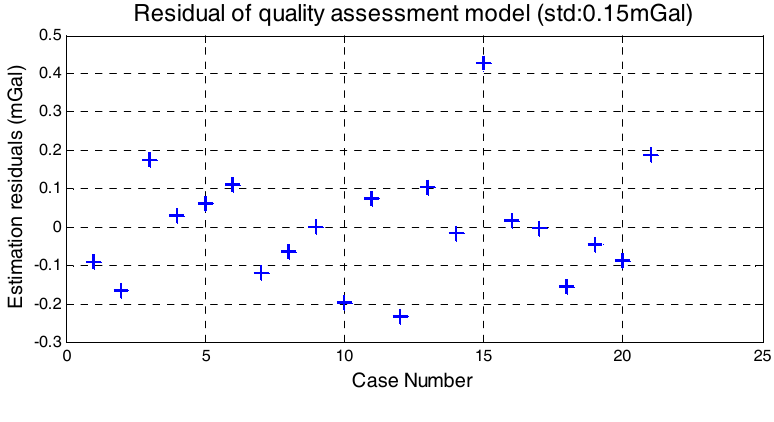
Figure 8. Model Figure 8. Model residuals.